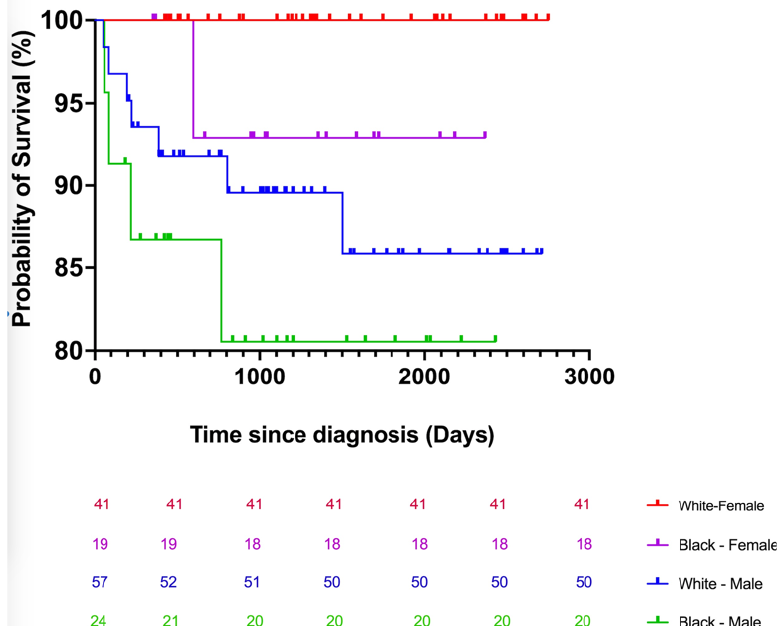
Figure 1. Overall survival of CTCL in Arkansas by Kaplan–Meier analysis.